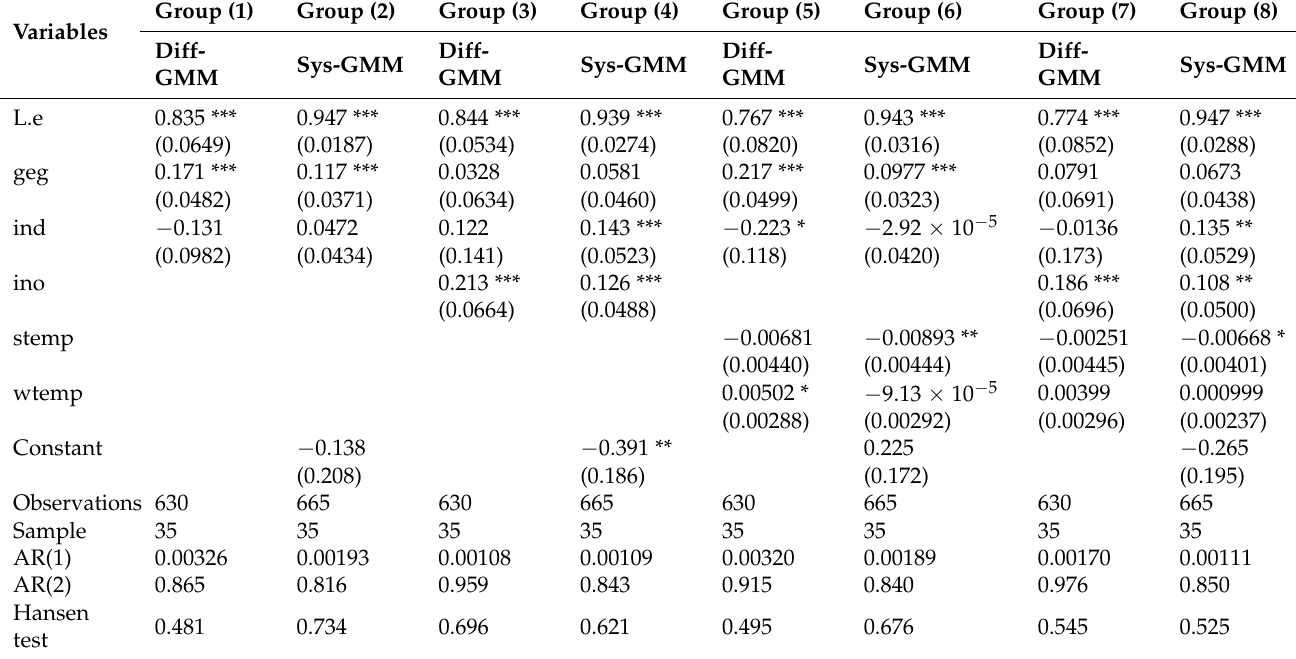
Table 6. The energy consumption function (OECD).